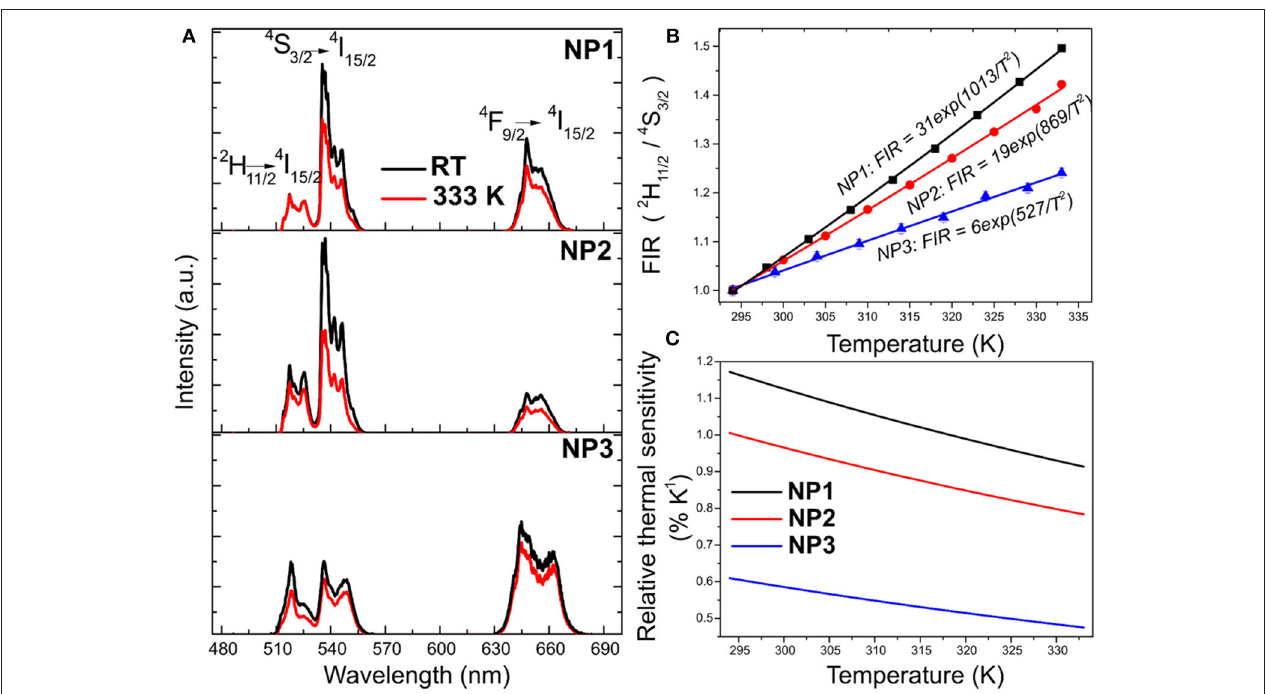
FIGURE 2 | (A) Upconversion emission spectra at room temperature (black) and 333K (red) for NP1, NP2, and NP3 samples. (B) Normalized FIR as a function of temperature for NP1 (black), NP2 (red) and NP3 (blue) samples with the corresponding fitting following a Bolzmann thermal distribution. (C) Relative thermal sensitivity as a function of temperature for the three samples [NP1 (black), NP2 (red), and NP3